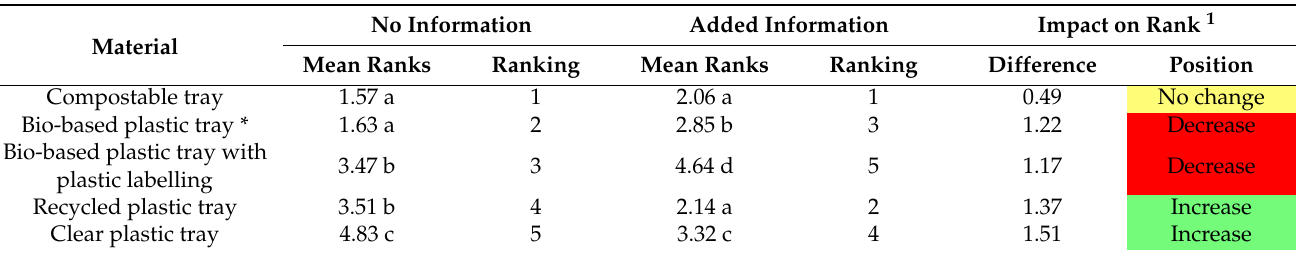
Table 4. Consumers ( n = 405) ranked order of various packaging based on perceived sustainability and the role of information on the subsequent order.